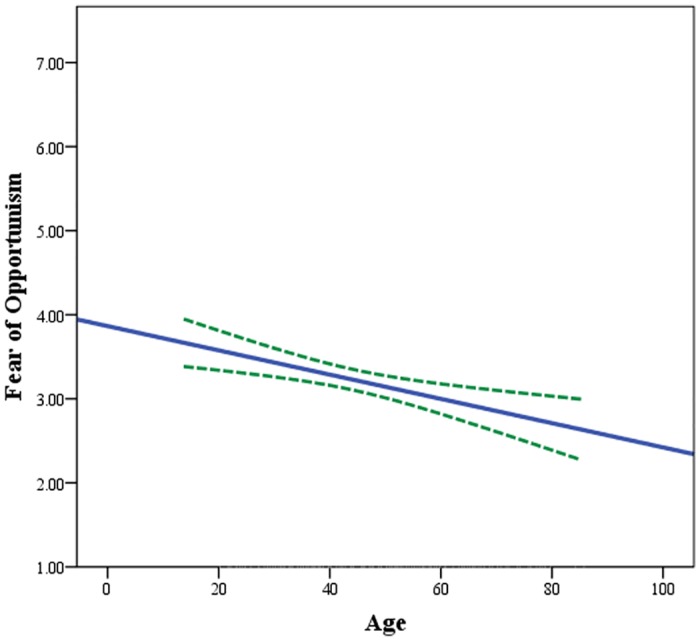
Estimated influence of age on fear of opportunism.The estimation is based on ordinary least squares linear regression. Blue line shows the estimated association between age and fear of opportunism while green lines show the 95% confidence intervals for this estimation.